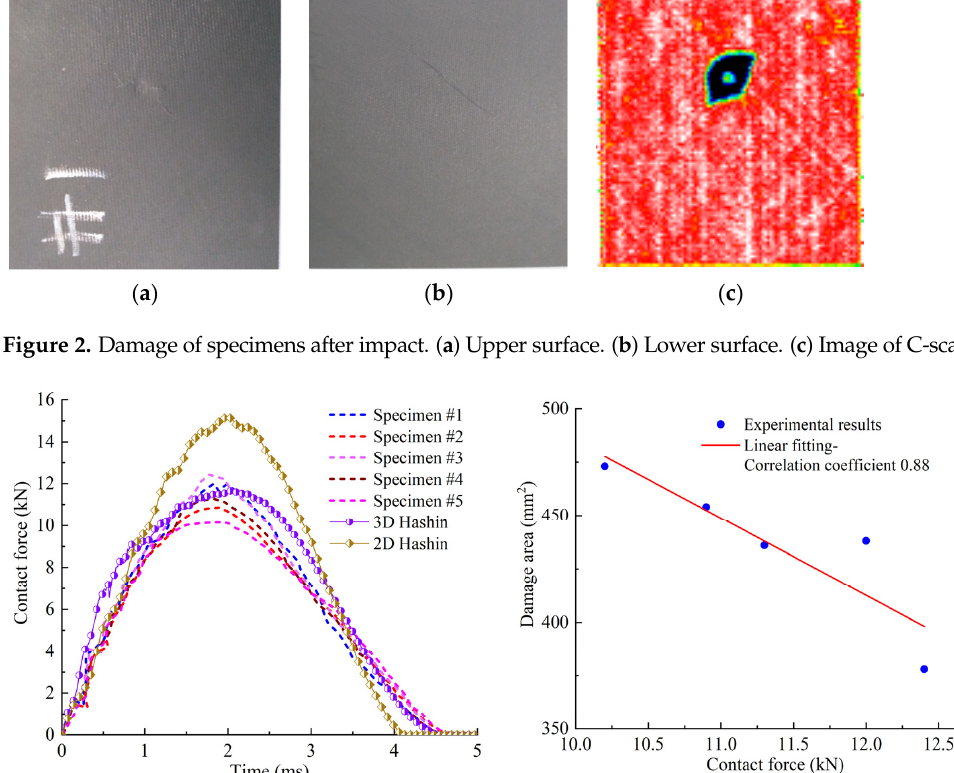
Figure 3. Contact forces and damage areas of specimens. ( a ) Comparison of the contact force during impact. ( b ) Relationship between damage area and contact force.